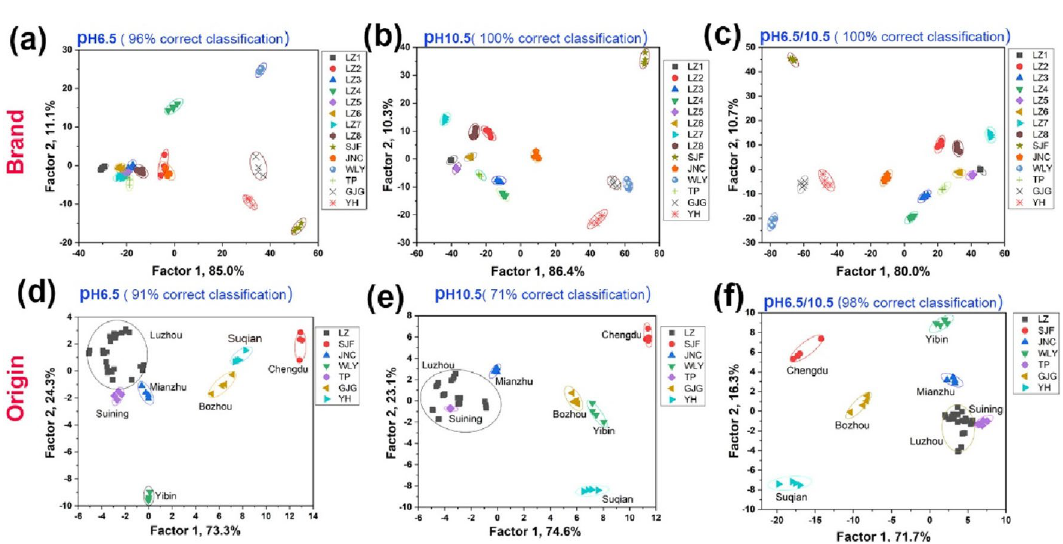
Figure 6. Two-dimensional canonical score plots for the first two factors of ( a – c ) 14 brands and ( d – f ) 7 origins obtained using the sensor array based on AA@AuNPs at the pH of ( a , d ) 6.5, ( b , e ) 10.5, and ( c , f ) 6.5 and